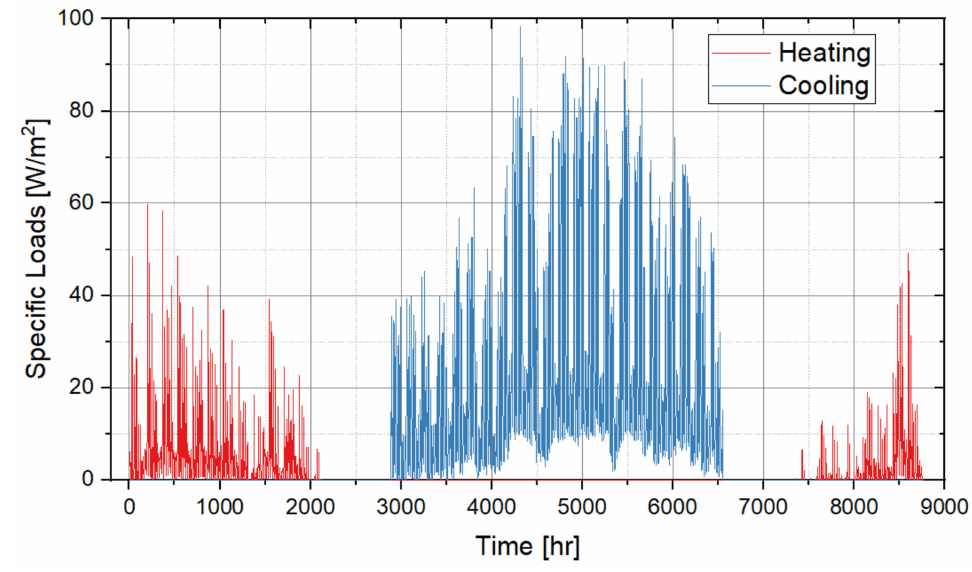
Figure 22. Predicted hourly total cooling and heating loads of the district energy system.